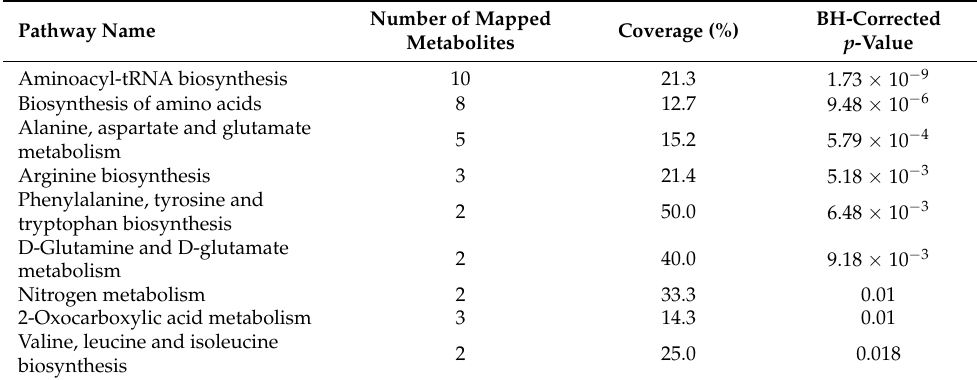
Table 1. Metabolic pathways significantly enriched in DON-exposed intestinal explants.